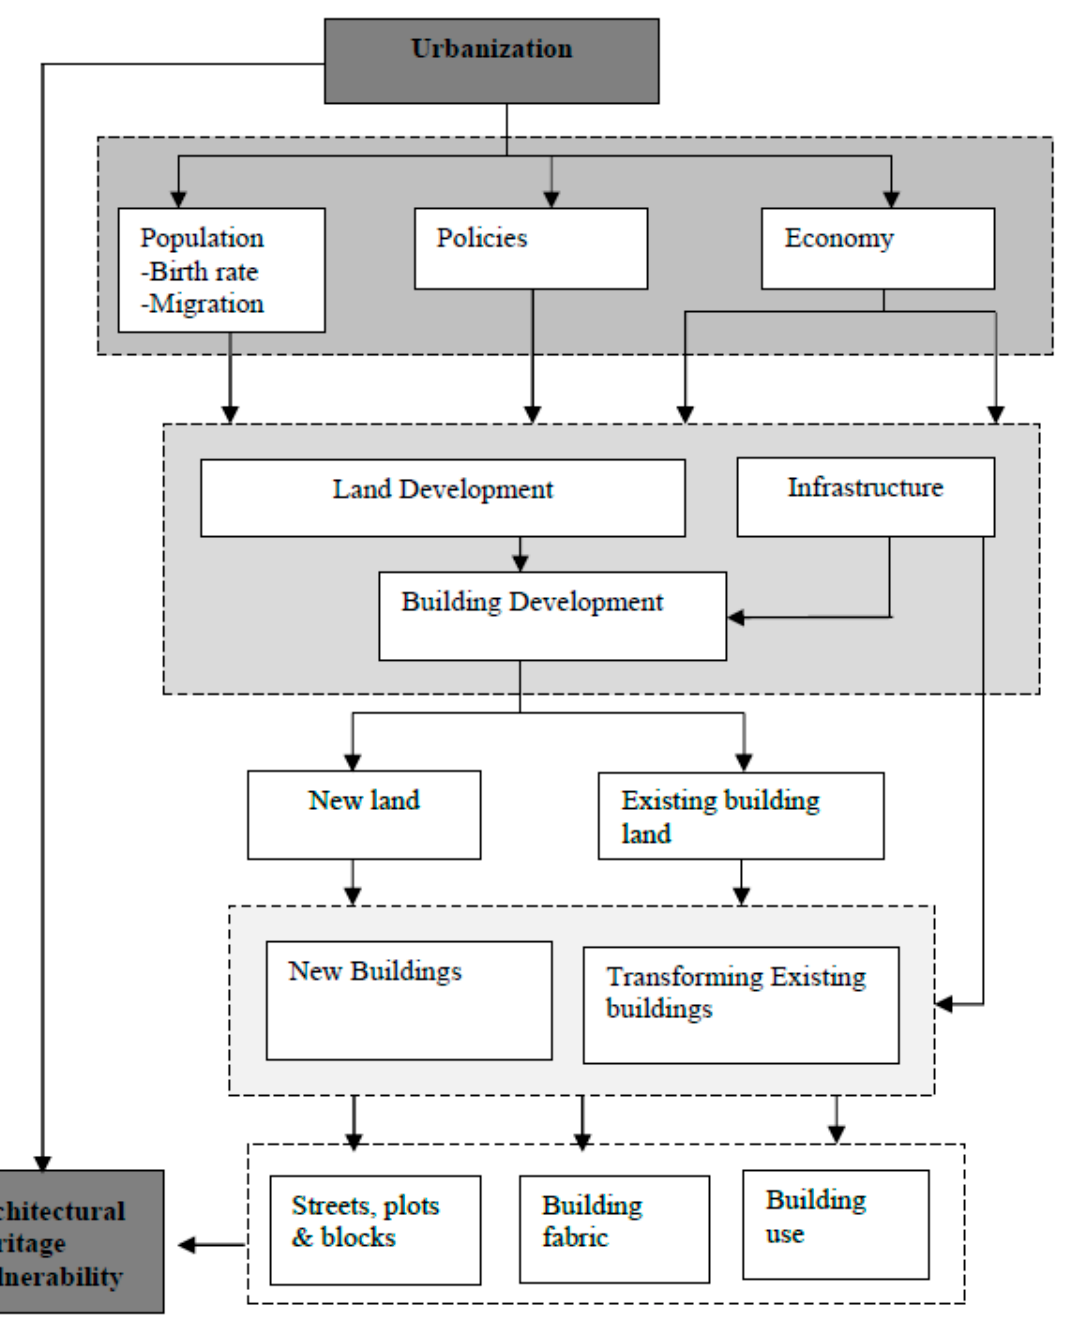
Figure 1. Conceptual framework (Source: Author, 2020).